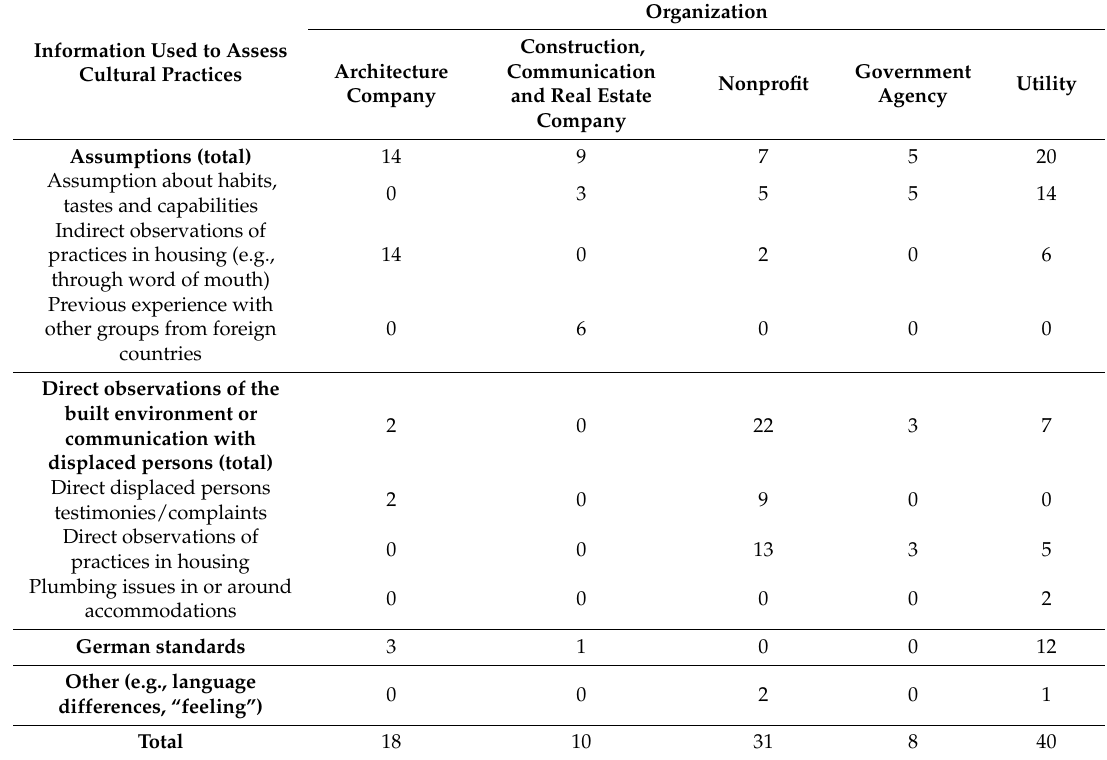
Table 4. Organization and frequency of information type used to (de)legitimize inclusion of cultural practices in the planning of water and sanitation services at the building and system